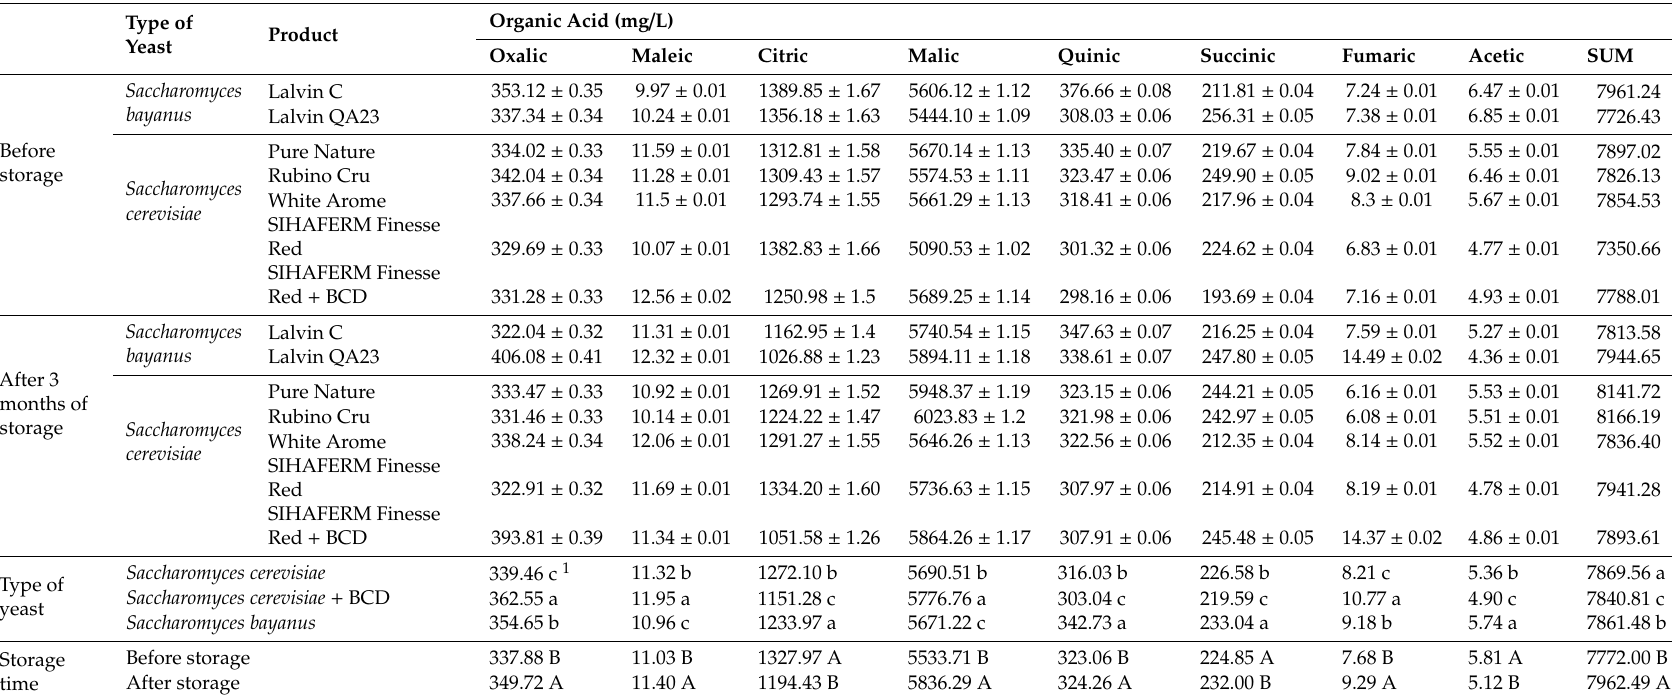
Table 2. The content of organic acid in red apple ciders